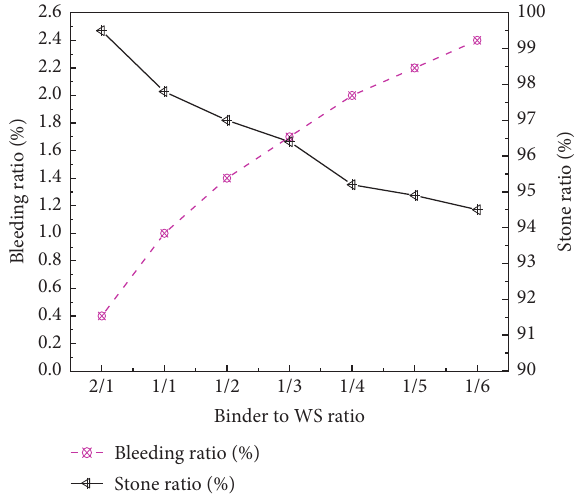
Figure 7: The bleeding ratio and stone ratio of the waste sediment- based grouting material with different binders to WS ratios.